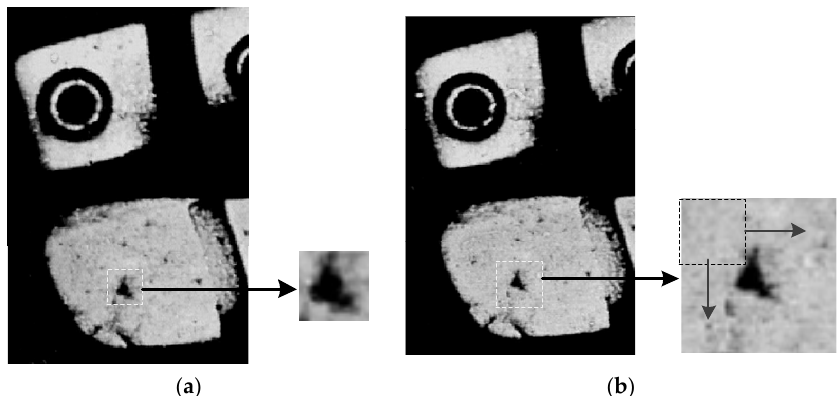
Figure 9. Illustration of template matching method. ( a ) The probe patch; ( b ) The extension patch in the questioned shoeprint.